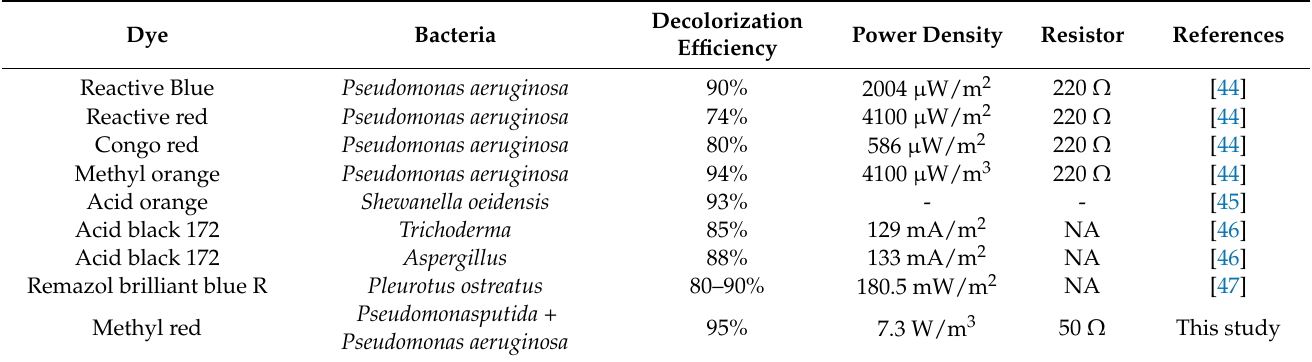
Figure 5. Polarization plots for MFCs (power density and DC voltage as a function of current density) with MFCs with different dye (Methyl red) concentrations as anolyte. The voltage and volumetric power density data points are presented as solid and open symbols. Table 2. Showing microbial dye degradation efficiency with power